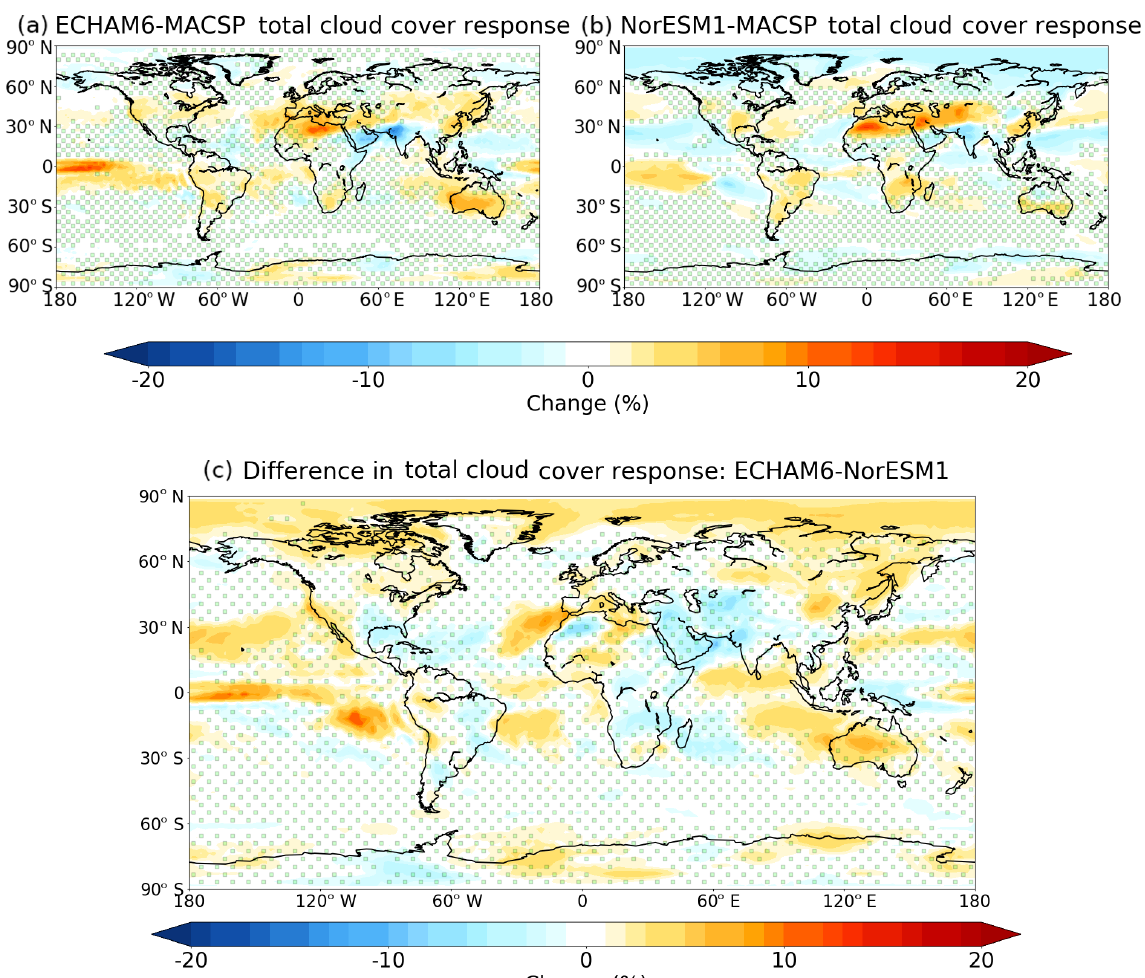
Figure C3. Total cloud cover response to the addition of anthro- pogenic aerosols. (a) Response in the ECHAM6-MACSP experi- ment; (b) response in the NorESM1-MACSP experiment; (c) the difference in responses between the experiments. The green dots represent the area where anthropogenic aerosols do not have a statis- tically significant impact at the p < 0 . 05 level (in panel c ) or where the difference between the models is not statistically significant (in panels a and b